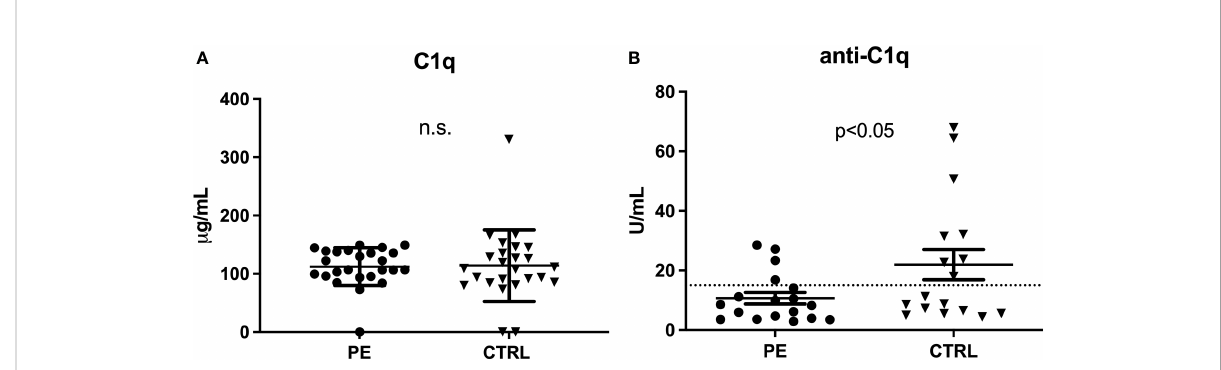
FIGURE 3 C1q and anti-C1q levels in the fi rst trimester of PE patients. Measurement of C1q (A) and anti-C1q (B) in fi rst trimester pregnant patients who subsequently developed PE and healthy pregnant women (CTRL). Differences in the C1q levels were not signi fi cant (n.s.), while anti-C1q levels were signi fi cantly lower in PE compared to CTRL (p<0.05 with paired